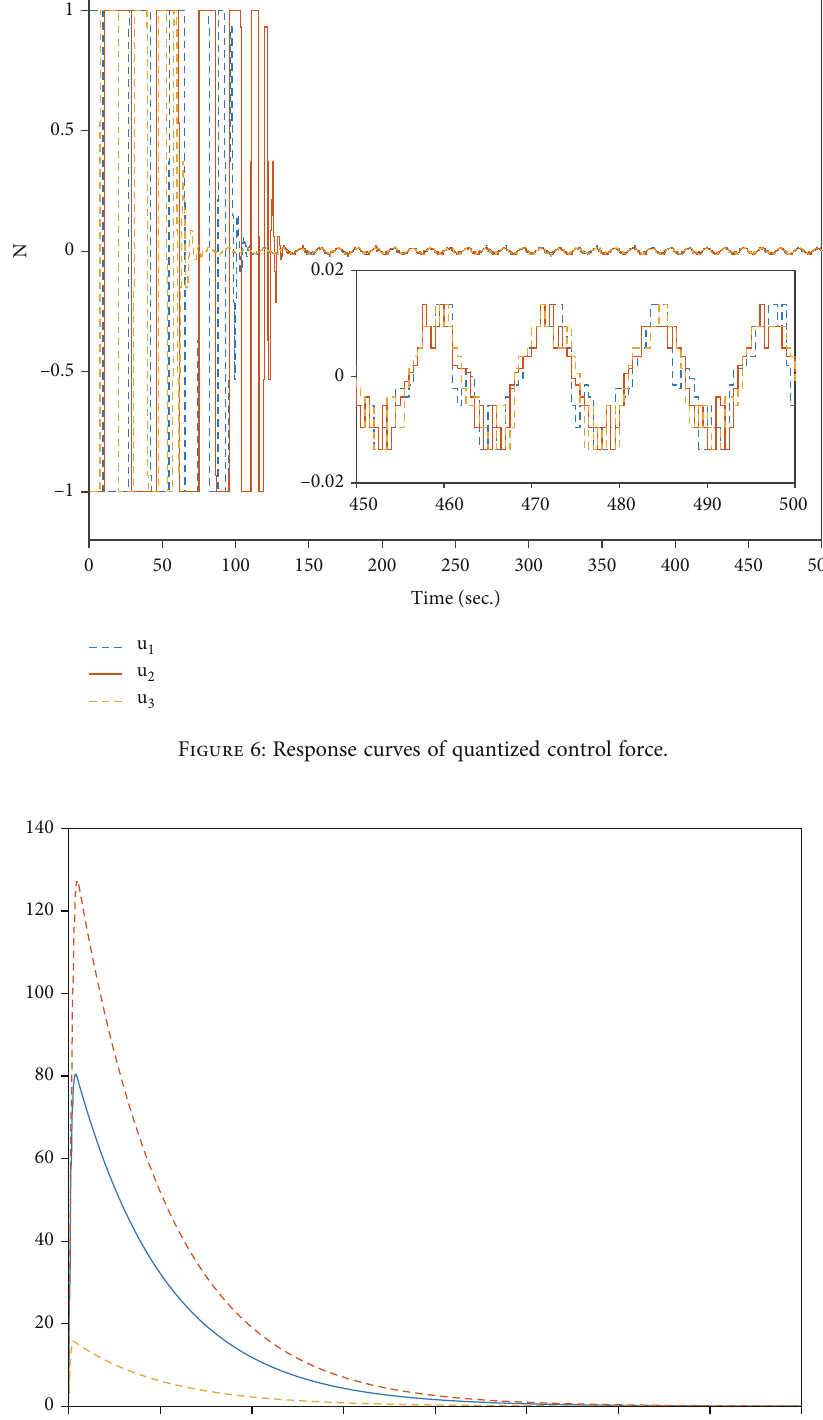
Figure 7: Response curves of the adaptive parameter b ψ